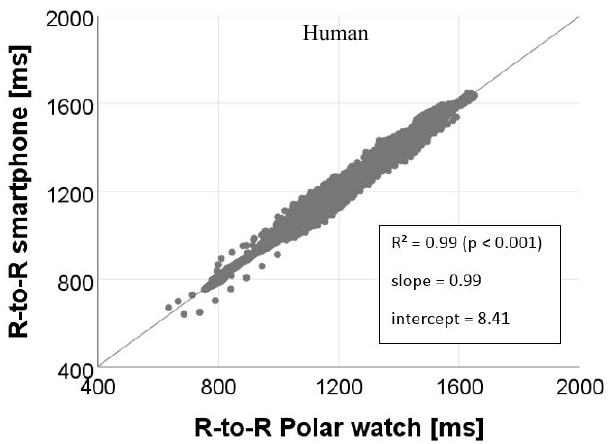
Figure 9. Relationships between RR intervals (R-to-R) (ms) derived from the smartphone IoTool application and Polar watch V800 for measurements on human. Table 1. Summary statistics of heart rate variability (HRV) parameters (mean ± SD) and validity statistics (correlation) measured via Polar watch V800 and smartphone IoTool application.